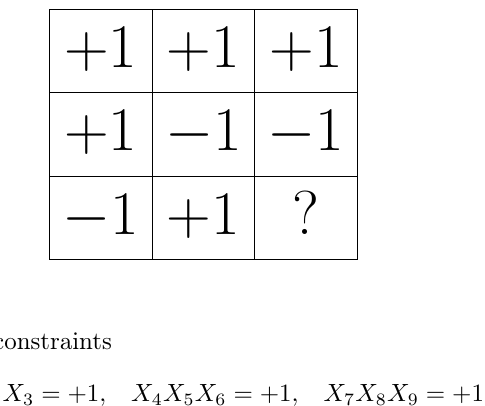
Table 2 . A classical optimal winning strategy to fill the 3 × 3